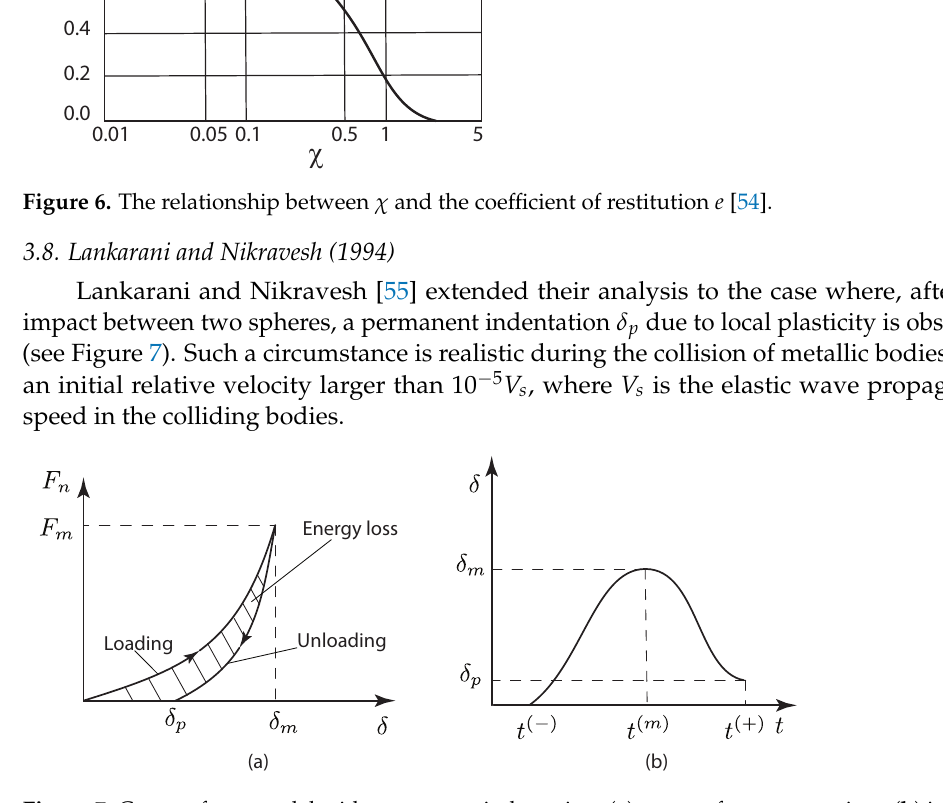
Figure 7. Contact force model with permanent indentation. ( a ) contact force versus time, ( b ) indenta- tion versus time